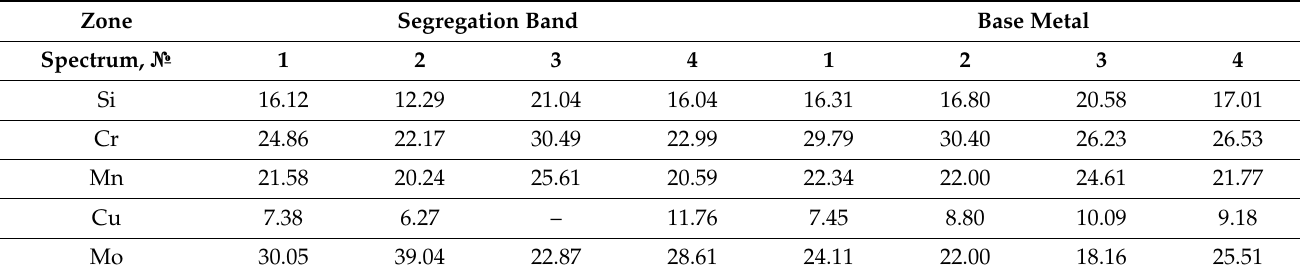
Figure 16. SEM images of carbides in segregations ( a ) and in base metal ( b ) in CT. Chemical composition (Table 7) shows that in carbides in segregations the content of molybdenum is increased. Table 7. Chemical composition of carbides in segregations and base metal of the CT sample, wt.